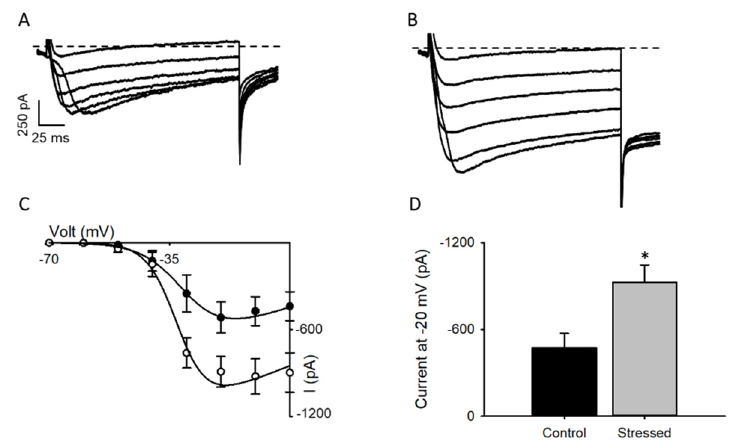
Figure 4. Chronic stress increases L -type calcium currents at CA1 pyramidal neurons: Representative whole-cell endogenous L -type Ca 2+ current traces from pyramidal neurons of CA1 of hippocampal slices from control ( A ) or subjected to CRS protocol ( B ) animals. Currents elicited by a voltage step protocol from − 70 to 0 in 10 mV increments, V h = − 80 mV. ( C ) Summary peak current I/V plots (mean ± sem) obtained from currents family, as shown in (A, black circles) and (B, white circles), where the black line represents the best fit to a Boltzmann equation. ( D ) Bar graph (mean ± sem) of the mean L - type current obtained at − 20 mV ( n = 7); black bars represent control animals, and gray bars CRS- subjected animals, * p value < 0.05.